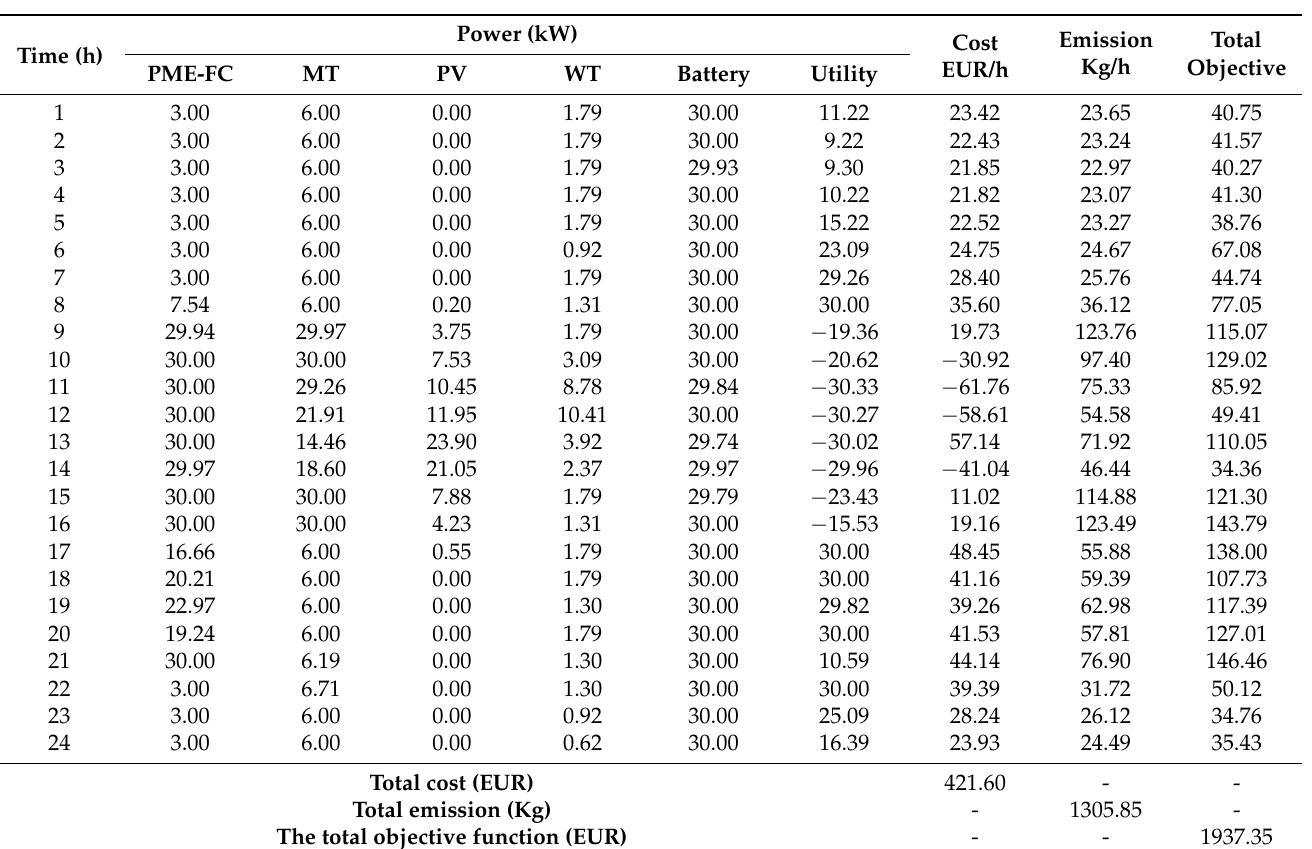
Table 4. The best results obtained using the EO for the EM problem for Scenario 1 (Case 2).